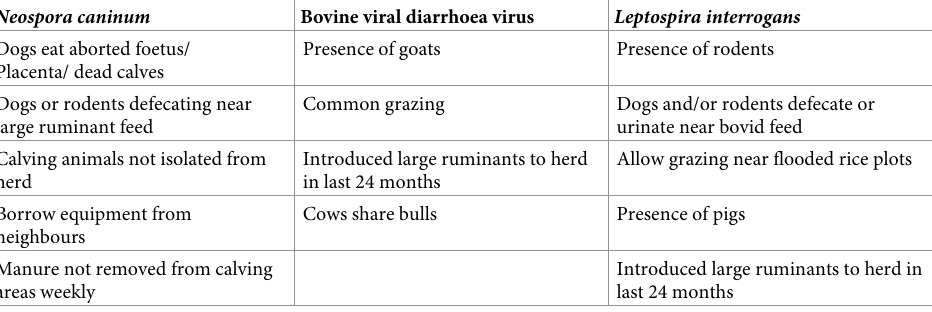
Table 3. Farm practices which pose risk of contracting reproductive pathogens in large